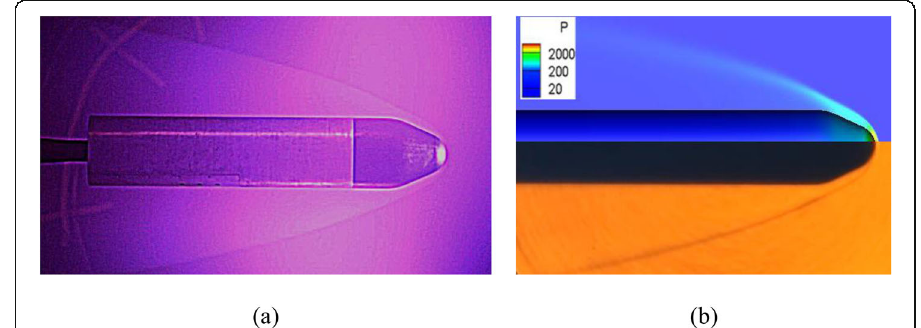
Fig. 7 Flow visualization results of HB-1 model under flow condition: Ma = 12, P 0 = 2 MPa, P ∞ ≈ 20 Pa, using methods of ( a ) electric glow discharge, ( b ) N-S simulation and schlieren